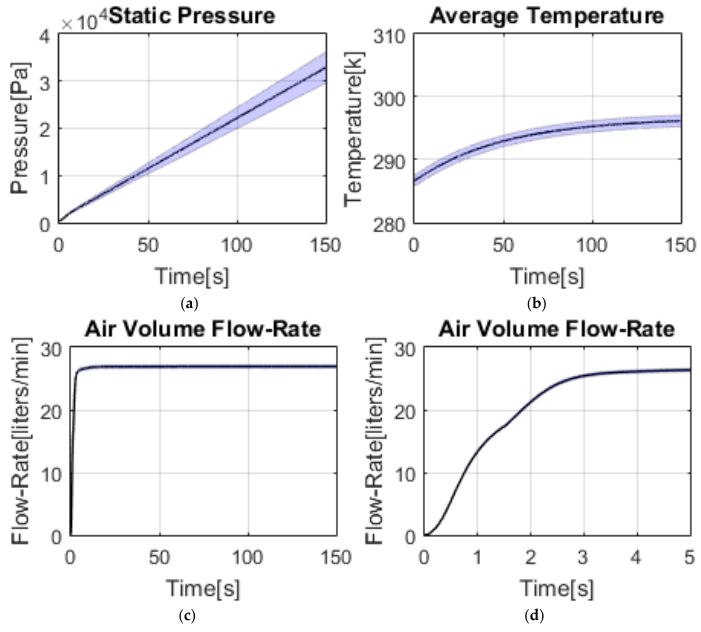
Figure 13. ( a ) Description of the pressure increase inside STARDUST-U during the air flow inlet at 27 L/min. ( b ) Description of the temperature variations measured during the experiment. ( c ) Description of the flow rate variation in the time. ( d ) Flow rate increase in the early stage from the accident experimental simulation.